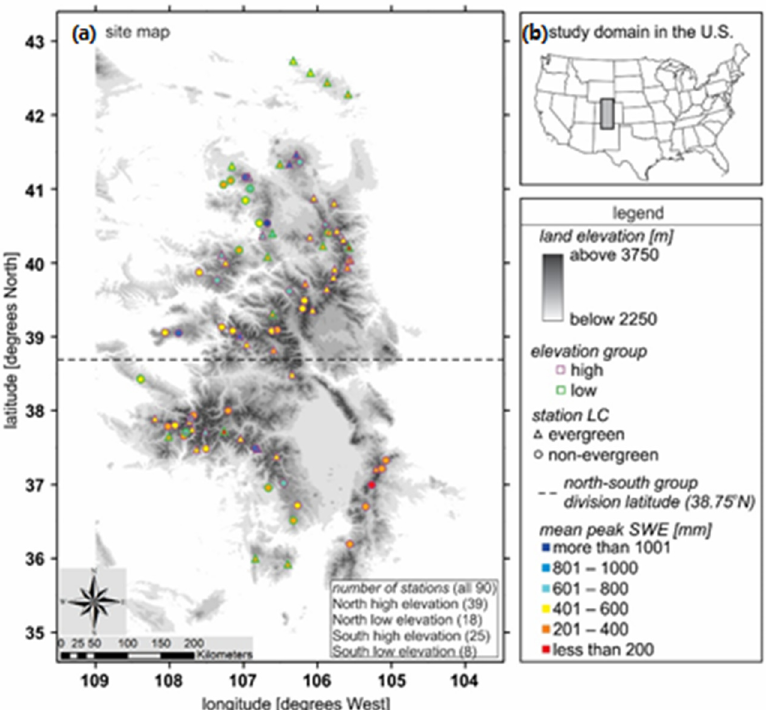
Figure 1. Location of the stations ( a ) as the study map illustrating the elevation group (high is 2800 m in the north and low is 2900 m in the south), land cover (evergreen/non-evergreen) and mean peak SWE (mm) of 90 SNOTEL stations across the Southern Rocky Mountains. The latitudinal division is noted by the dashed line. The study area is ( b ) located in the Western United States. The number of stations in each group (Section 3.1) is presented in ( a ).